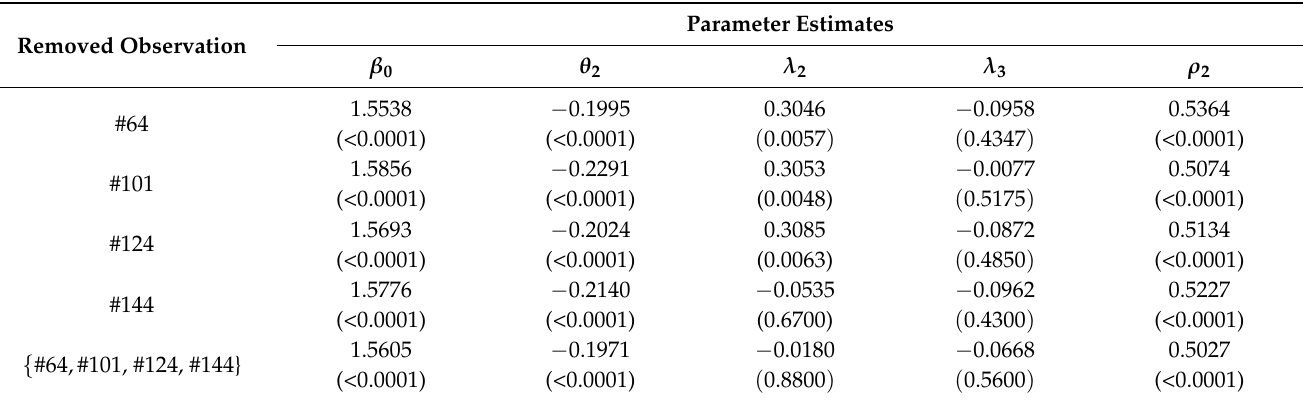
Table 6. Maximum likelihood estimates and p -values in parentheses for parameters θ 2 , λ 2 , λ 3 , and ρ 2 of the Weibull regression model after removing the points.